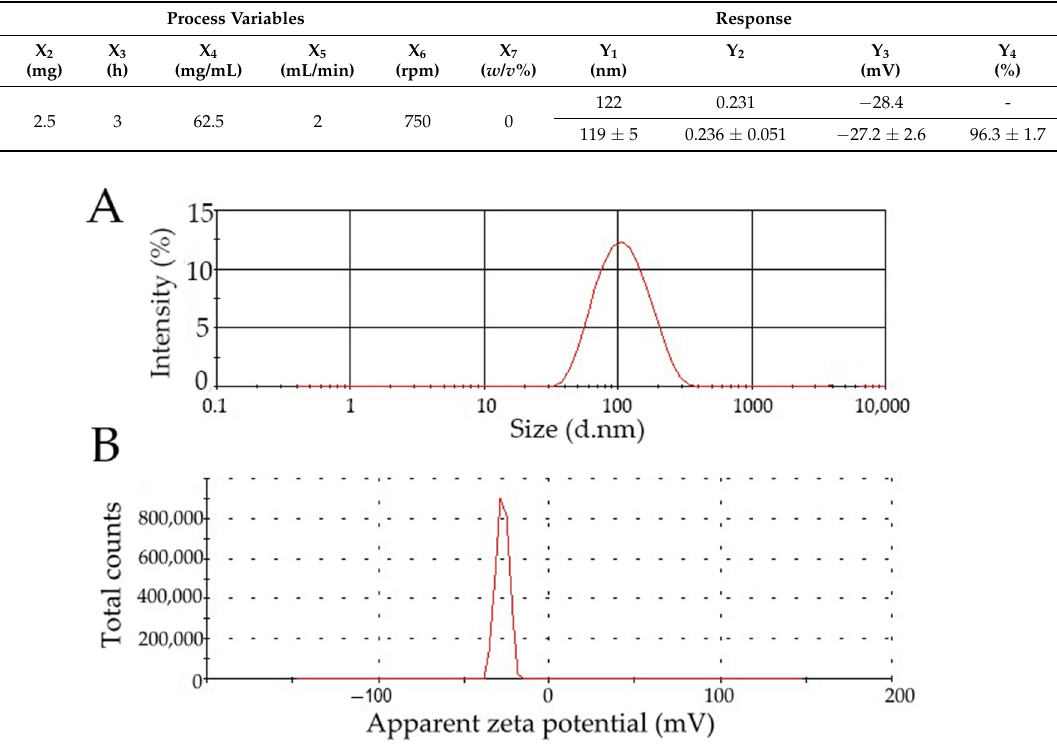
Table 12. Model confirmation of the design of the experiment: X 1 : Amount of EtOH (mL), X 2 :